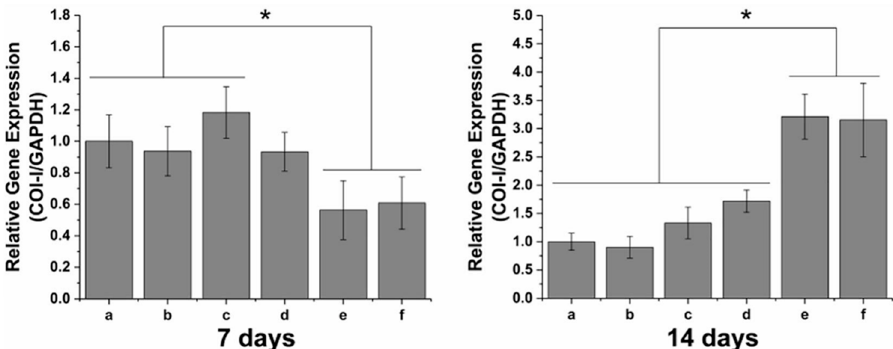
Figure 14. Quantitative polymerase chain reaction (qPCR) analysis of type 1 collagen expression by mouse embryonic fibroblast cells cultured on ( a ) poly(lactic-co-glycolic acid) (PLGA), ( b ) PonG1@PLGA, ( c ) DOPA-PonG1@PLGA, ( d ) bFGF@PLGA, ( e ) DOPA-bFGF@PLGA, and ( f ) DOPA-